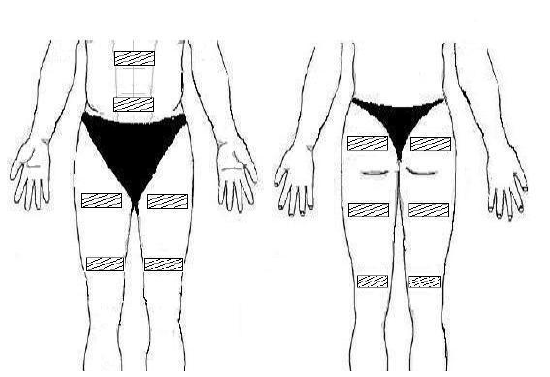
Figure 1. Locations of stimulation